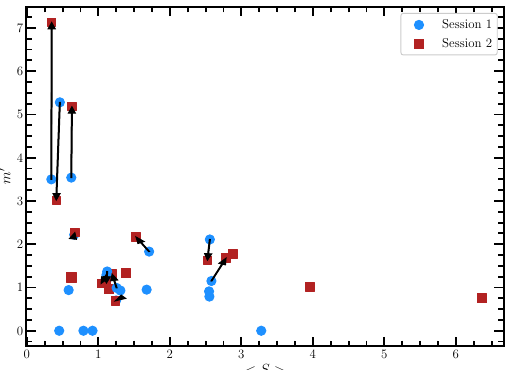
Figure 4. The modified modulation index ( m (cid:48) in per cent) versus average flux density ( < S > , in Jy) of the target sources observed in session 1 (blue circle) and session 2 (red square). Arrows indicate from session 1 to session 2 for 11 common target